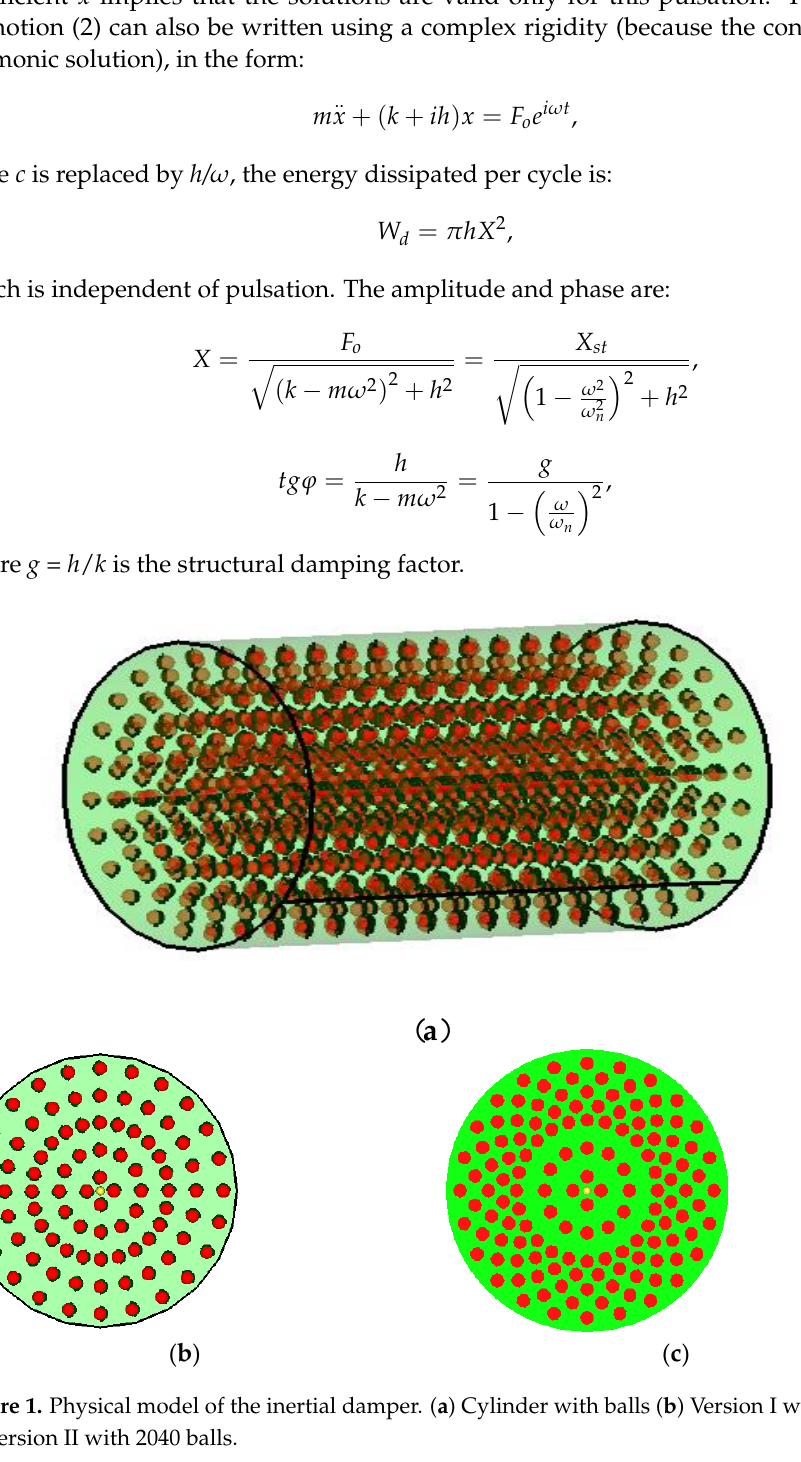
Figure 2. Model no. 1 for the damper with 1320 balls. In Figures 2 (see Table 1) and Figure 3 (see Table 2), the two versions of the model used are presented, including the model with 1,320 balls and model with 2,040 steel balls.